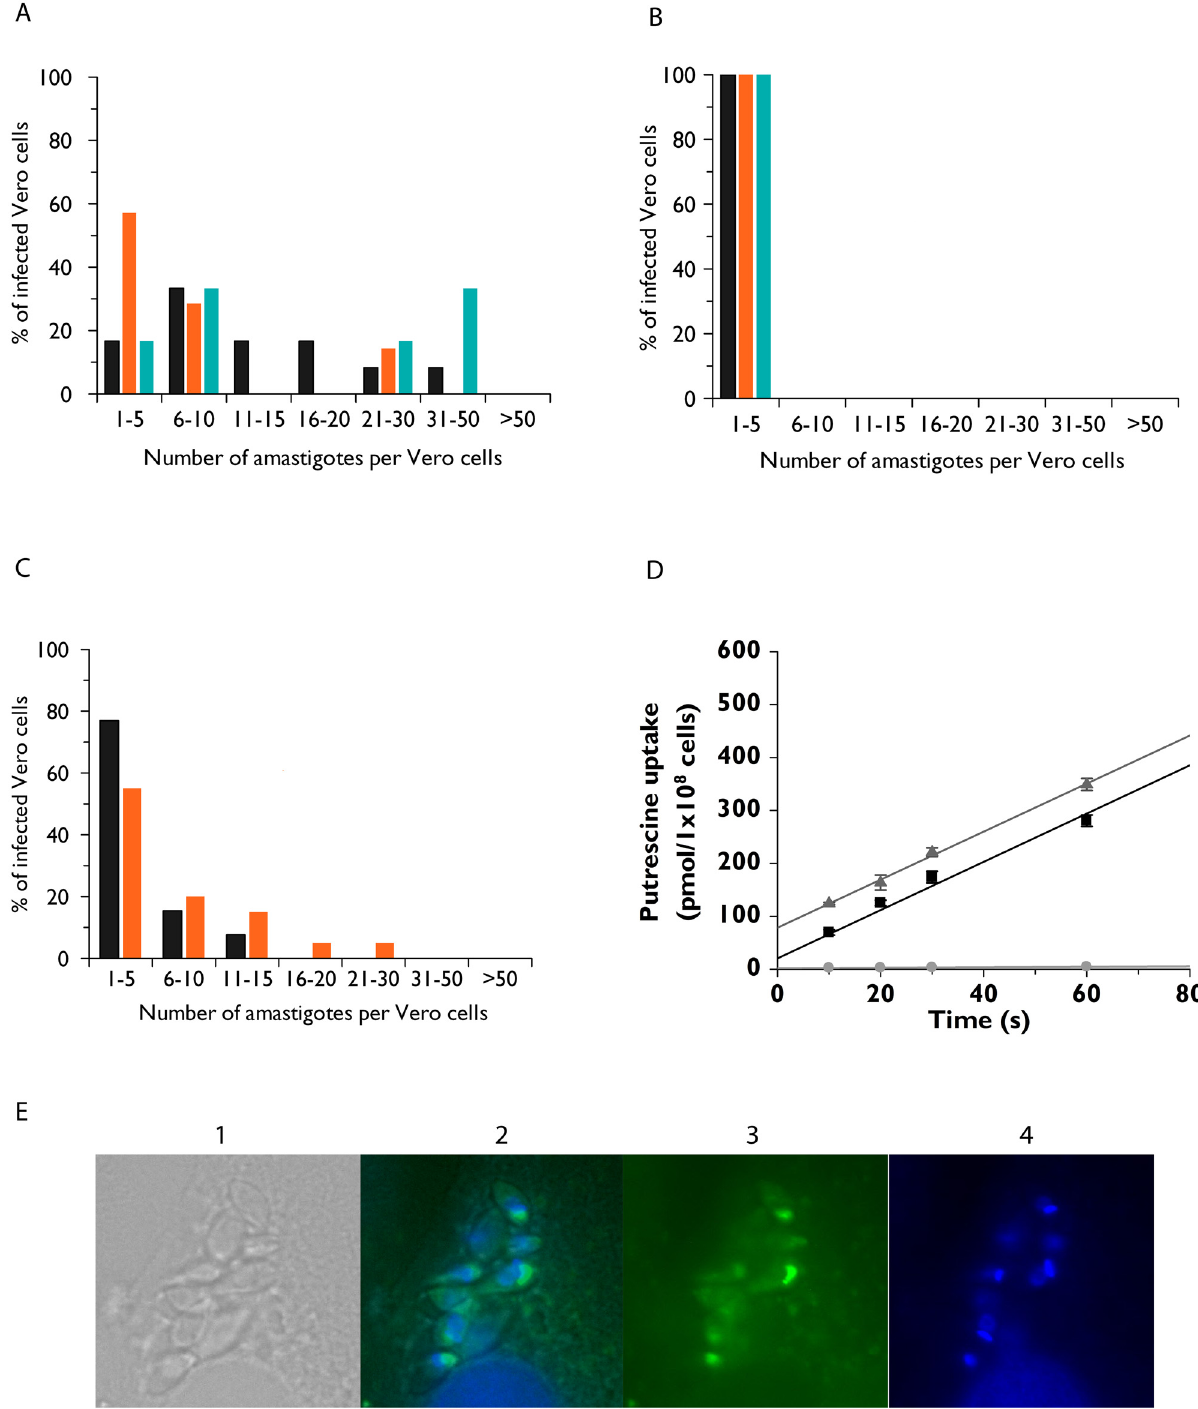
Fig 6. Parasite loads in mammalian cells infected with either wild type, Δ tcpot1 , or Δ tcpot1 [p TcPOT1 ] “ add-back ” parasites. Vero cells were infected with (A) wild type, (B) Δ tcpot1 , or (C) Δ tcpot1 [p TcPOT1 ] metacyclic trypomastigotes at a ratio of five parasites per cell and DAPI-stained amastigotes enumerated as indicated in the Experimental procedures section. Each color represents data from three independent experiments for the wild type and Δ tcpot1 cell lines and is indicated as n1 (black), n2 (orange), or n3 (blue), and data from two independent experiments for the “ add-back. ” Within each experiment amastigotes enumeration was performed in duplicate. (D) Demonstration that putrescine transport capability has been conferred by ectopic expression of TcPOT1 in the Δ tcpot1 [p TcPOT1 ] “ add-back ” line. Putrescine transport was measured as described for Fig 2 in wild type ( & ), Δ tcpot1 (grey